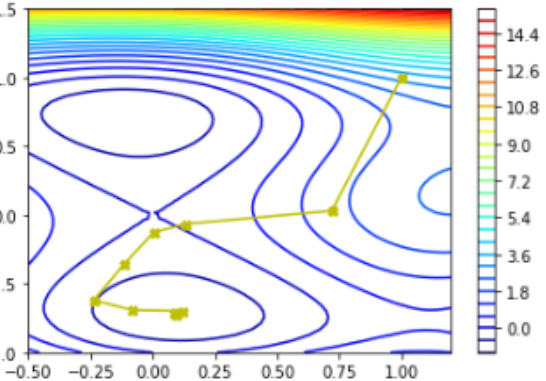
Figure 15. Global minima of SIX-HUMP CAMEL function using BFGS